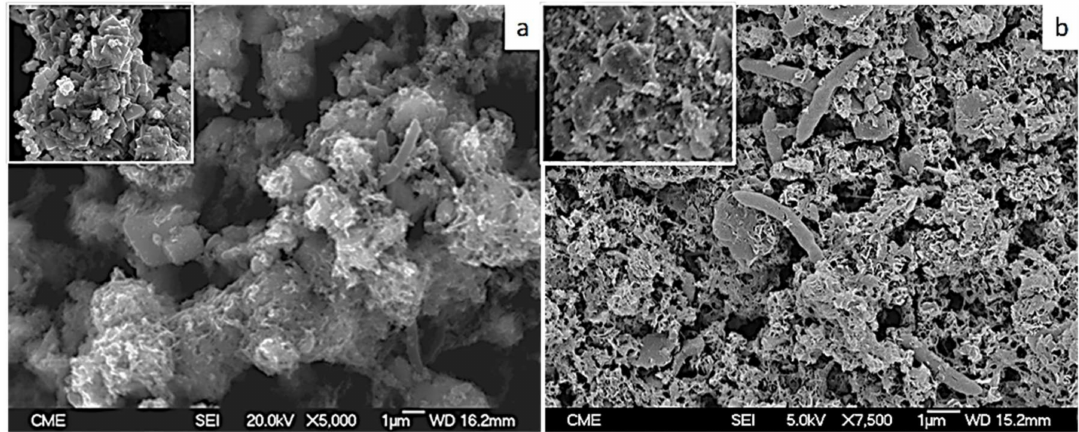
Figure 4. FE-SEM images of the mineral residues after incubation with microbes: ( a ) K- and NH 4 -jarosites, and ( b ) gossan ore. Insets show the raw minerals.